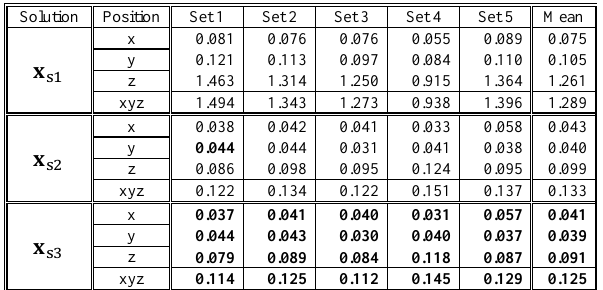
Table 2. Average positioning errors (Unit: metre)